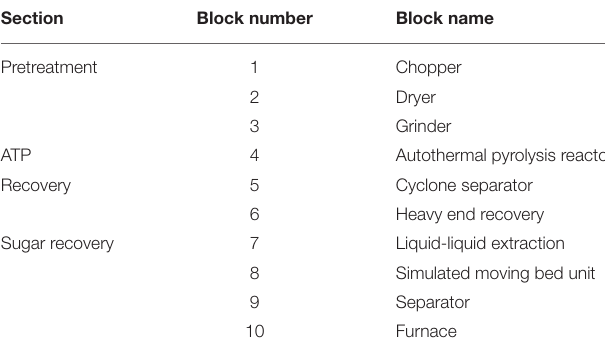
TABLE 1 | Autothermal pyrolysis flow diagram sections, block numbers, and names.